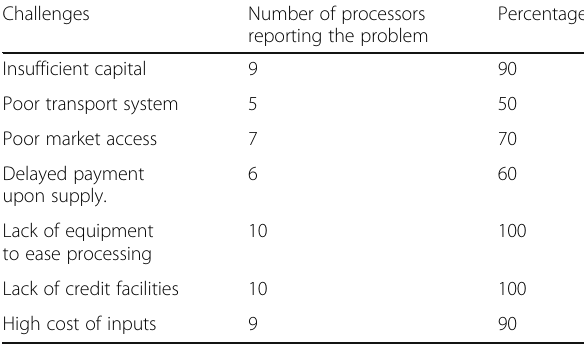
Table 4 Challenges faced by koche processors Challenges